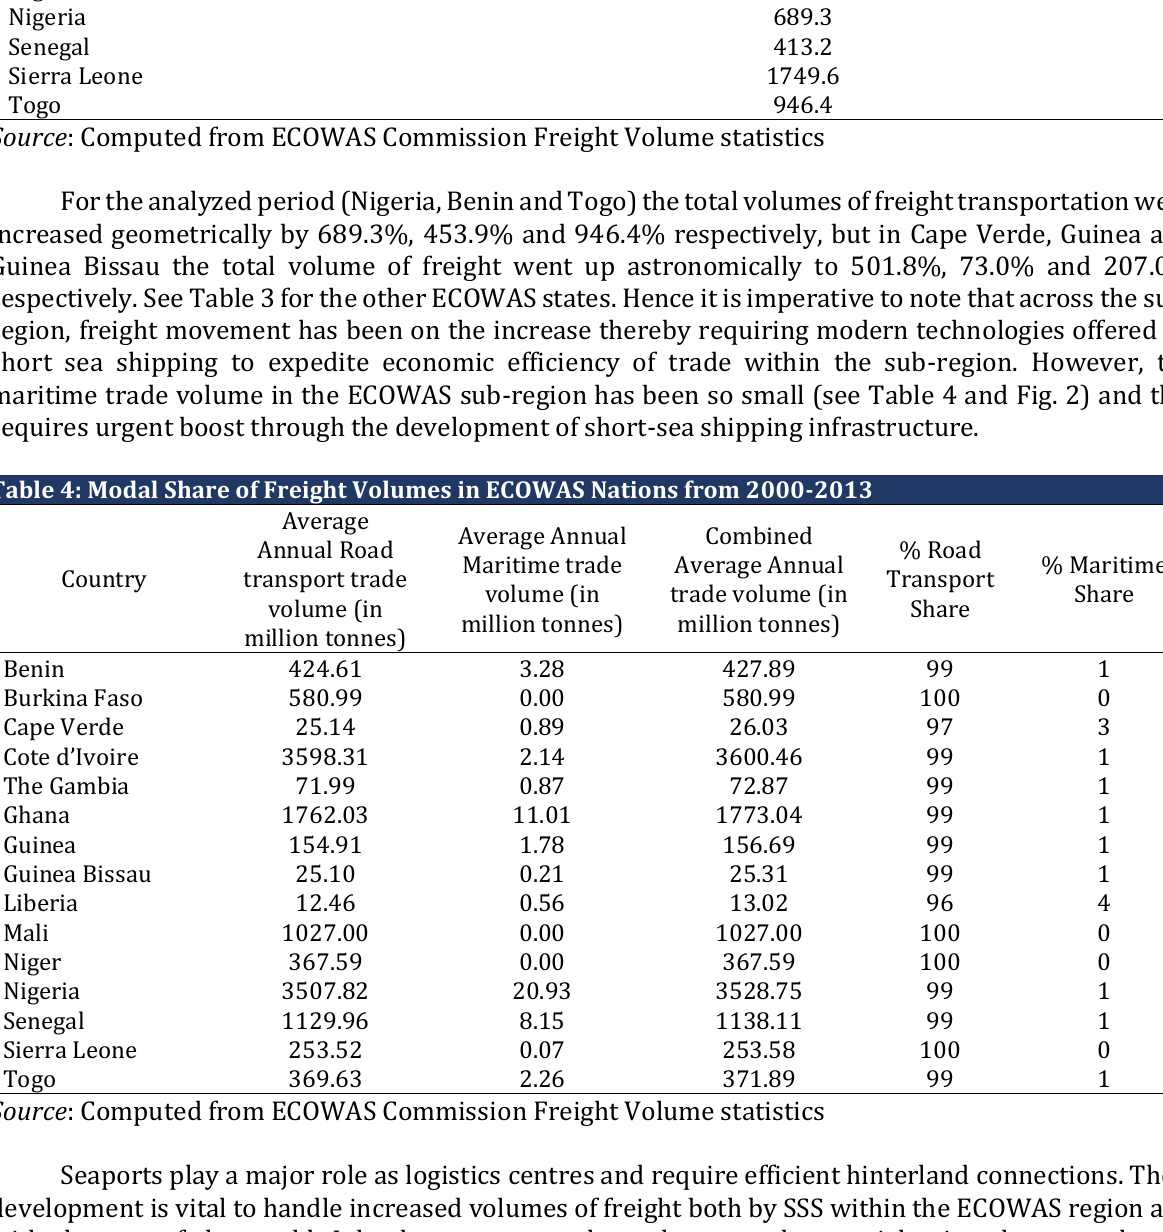
Percentage Change of Freight Volume between the periods 2000 and 2013